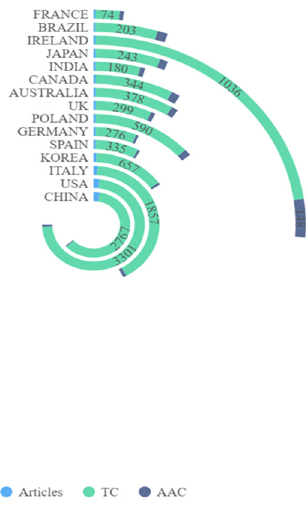
Figure 3. Top 15 contributing countries on microbiome–gut–brain axis and dementia-related research.